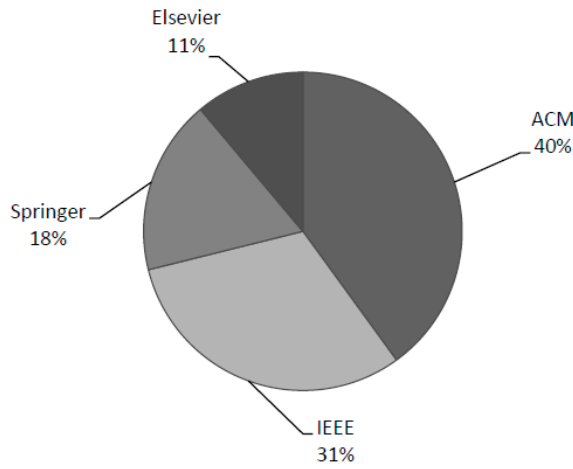
Figure 10. Publications distribution over publication forums.